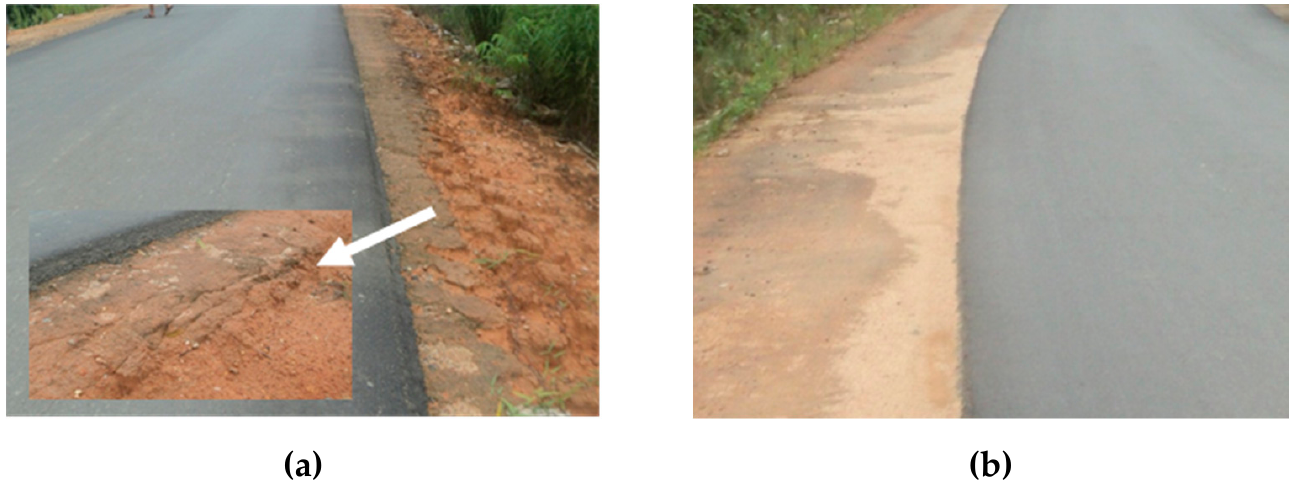
Figure 1. The appearance of soil-cement as a base ( a ) undergoing wetting–drying cycles, and ( b ) non-submerged road.